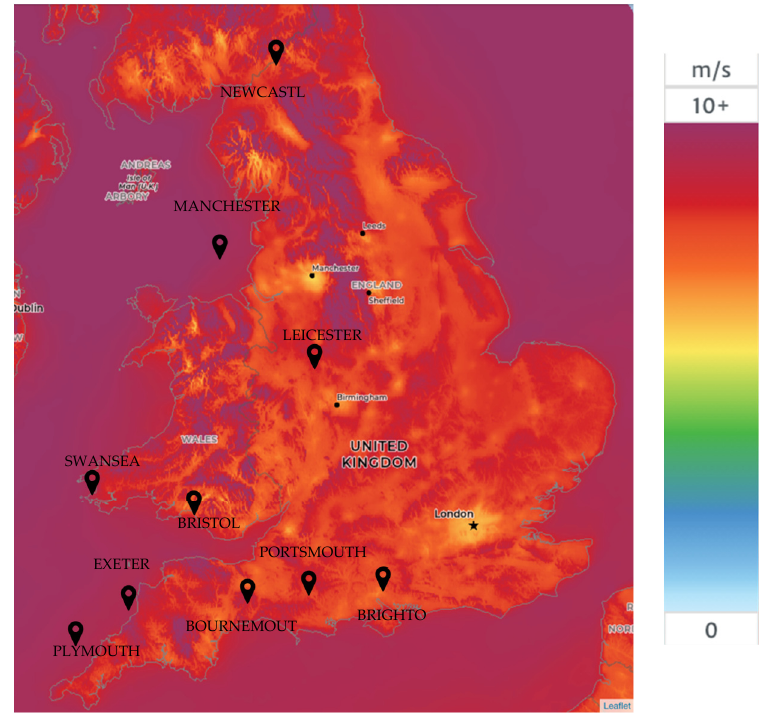
Figure 1. Solar atlas data of chosen locations [38].